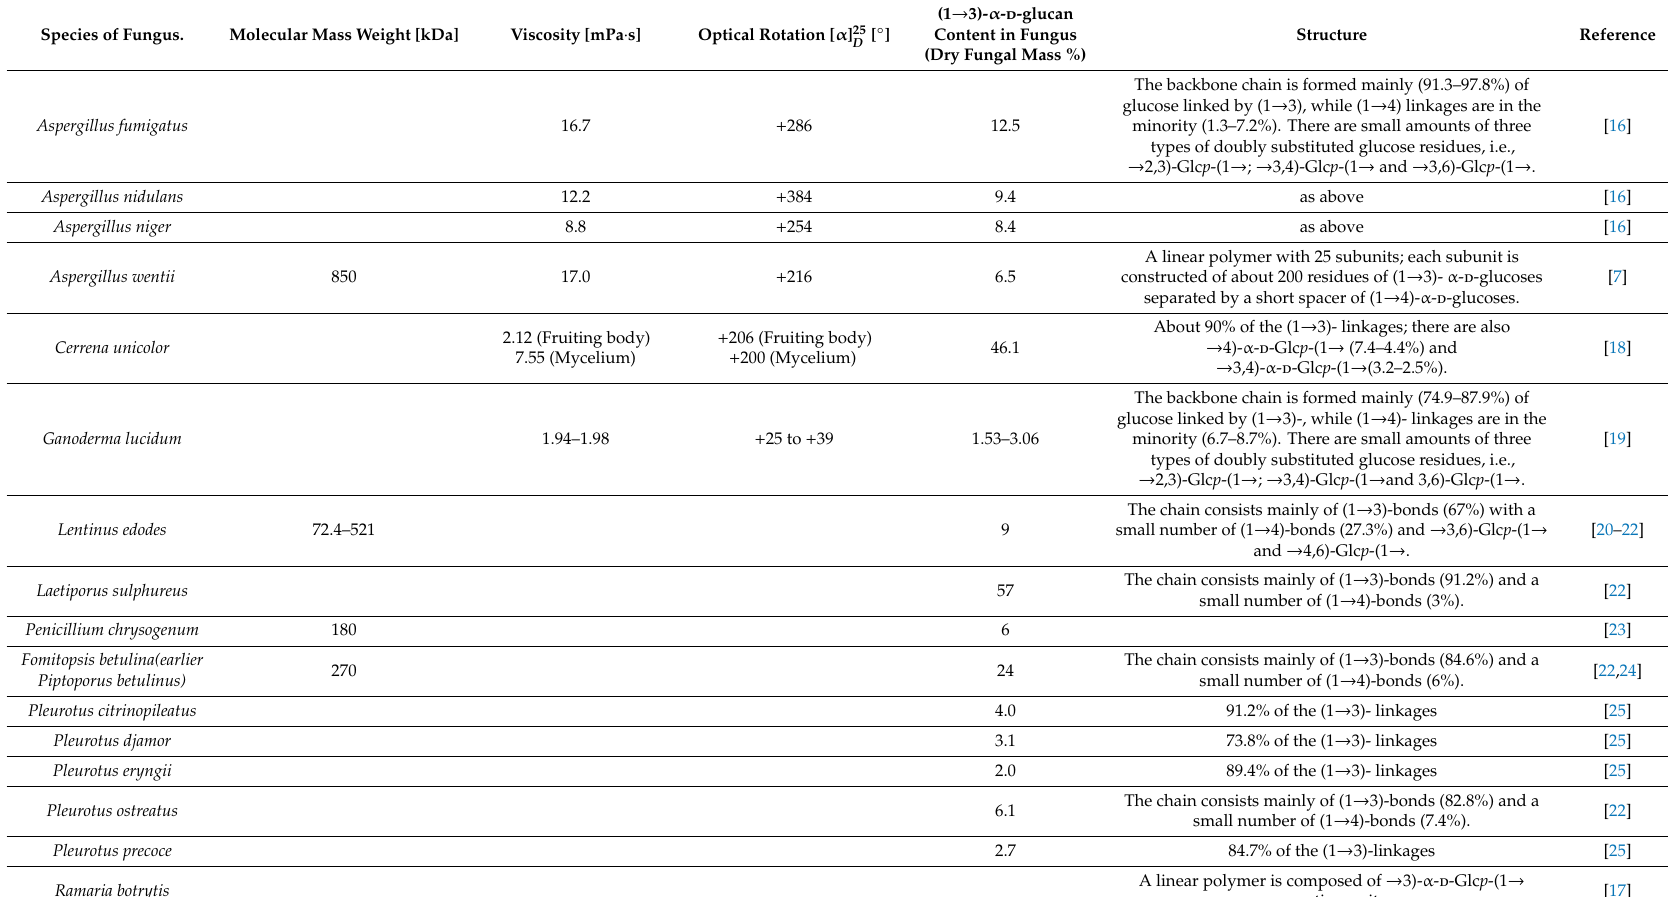
Table 1. Review of fungal species that contain (1 → 3)- α - d -glucans, along with their brief characteristics. Species of